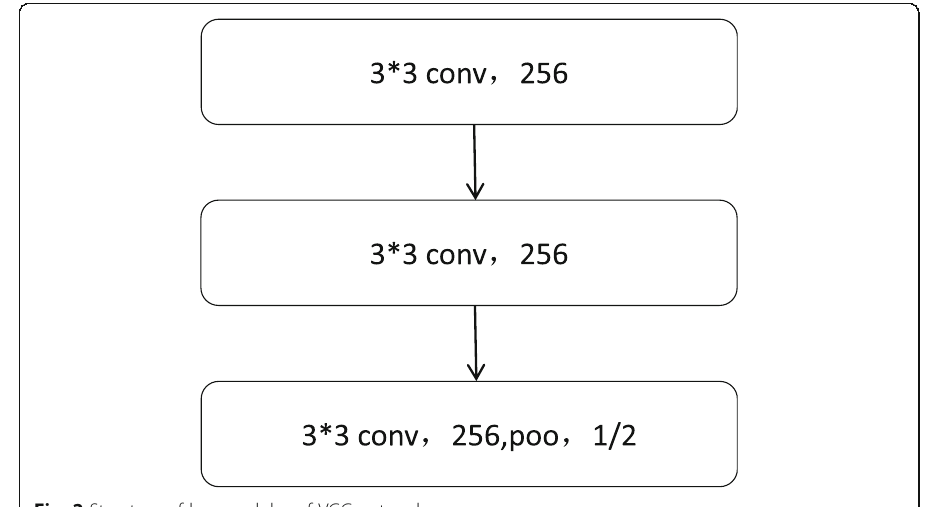
Fig. 2 Structure of key modules of VGG network